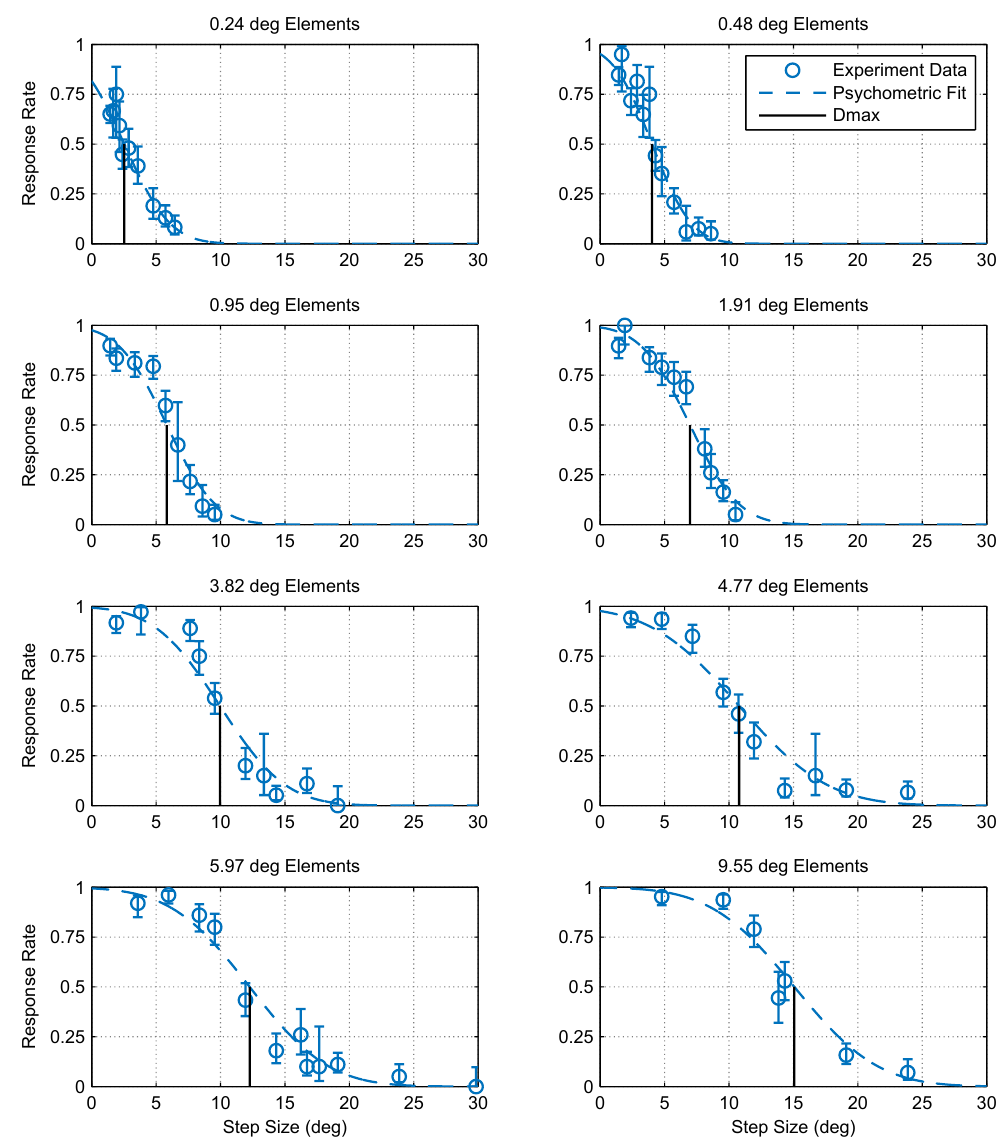
Figure 3. Optomotor response rates against step size for various element sizes. Error bars are 95% confidence intervals calculated using simple binomial statistics. Each panel shows the pooled responses of 13 mantids to a moving chequerboard stimulus of a given element size. The data and corresponding psychometric fits show that motion detection becomes increasingly more difficult (i.e., the response rate decreases) as the step size increases and the step size corresponding to a 50% response rate (Dmax) increases with element